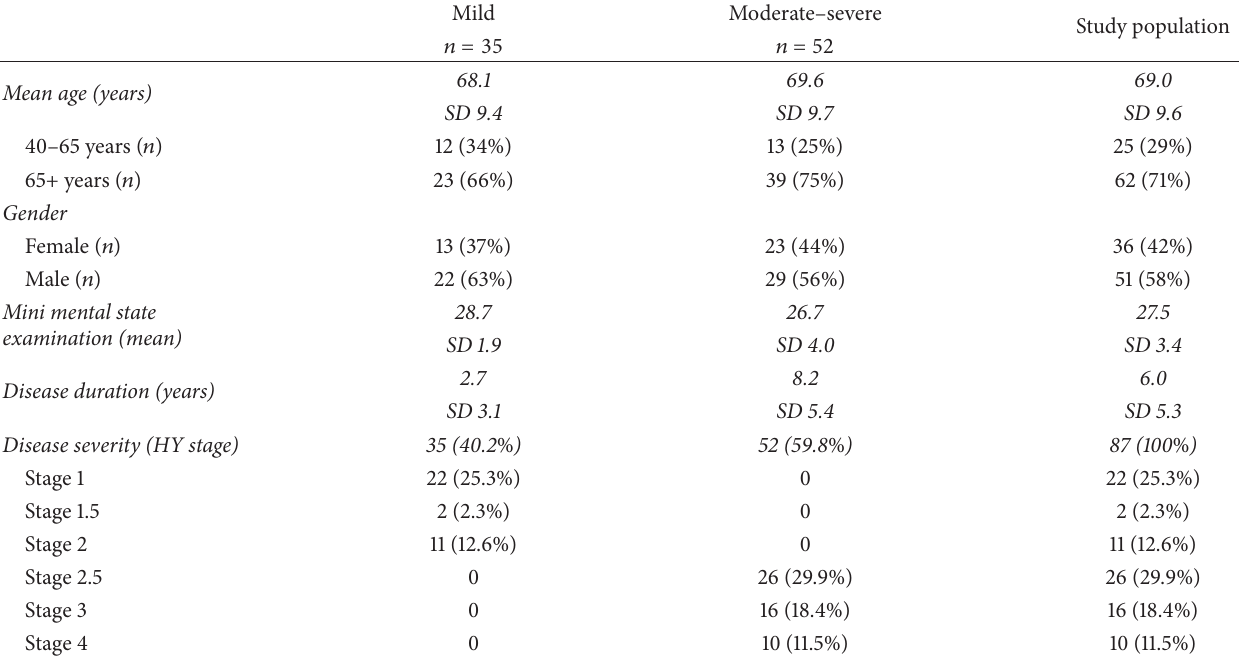
Table 3: Population